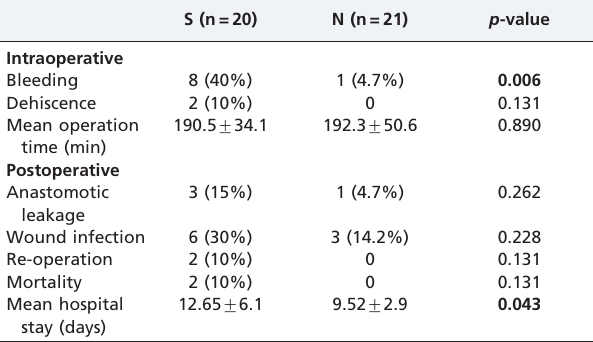
Table 3 - Intraoperative and postoperative patient